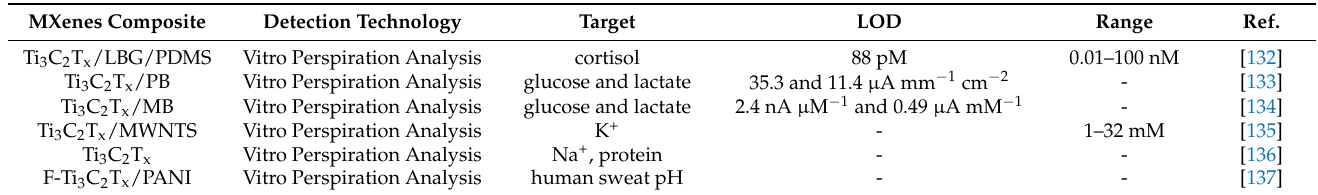
Table 7. MXene-based wearable biosensors identify units, target, and analytical parameters. MXenes Composite